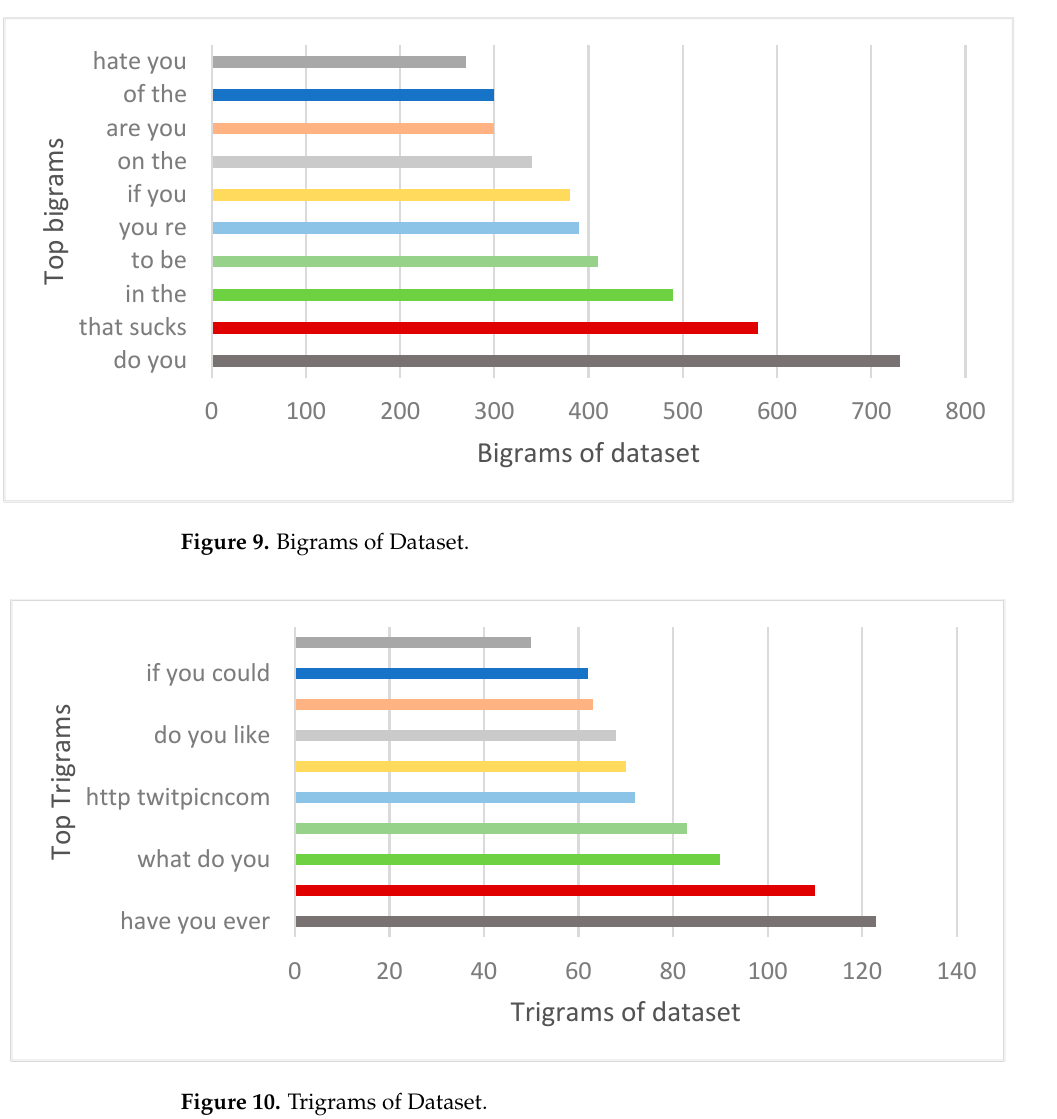
Figure 8. Unigrams of Dataset.